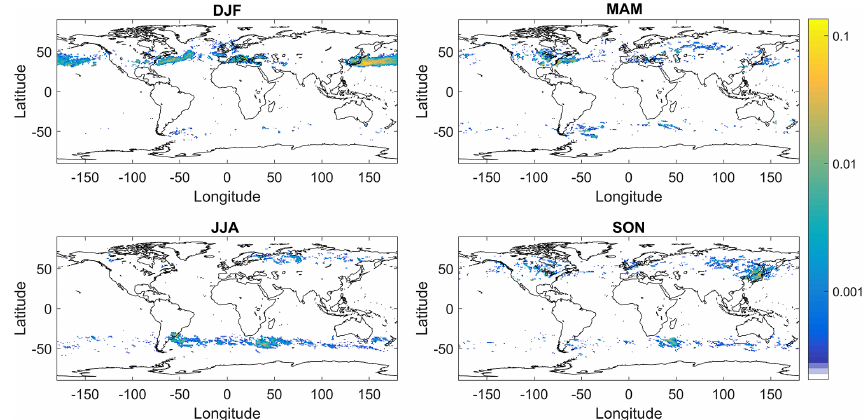
Figure 4. Seasonal variation of the winter lightning stroke density distribution for the period of 2009–2013. The values are calculated as the average number of strokes for the 5 years in each grid cell divided by the area of the cell. Note the major shift of activity from DJF and MAM periods in the Northern Hemisphere to more JJA and SON periods in the Southern Hemisphere.